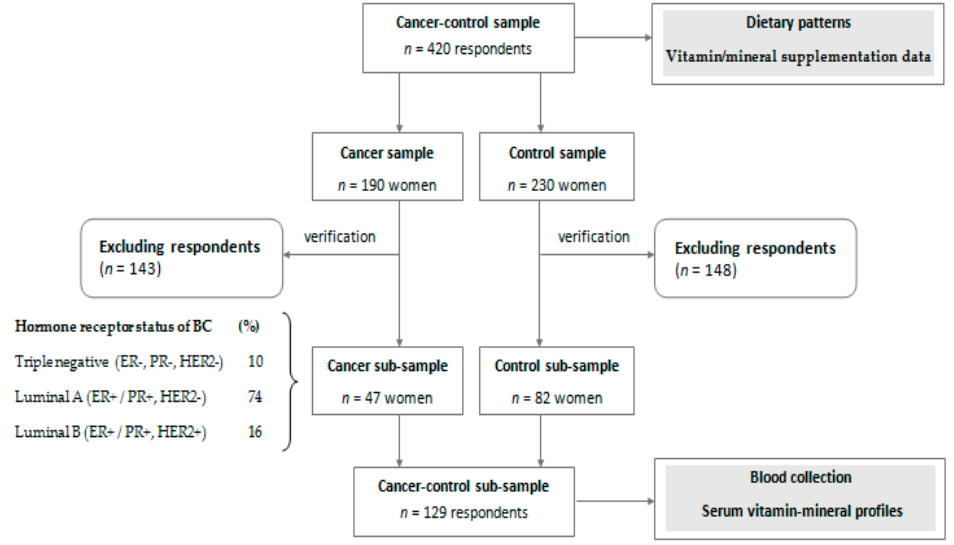
Figure 1. Study design and sample collection. BC—breast cancer; ER—estrogen receptor status of tumor; PR—progesterone receptor status of tumor; HER2—human epidermal growth factor receptor 2. Table 1. Criteria of the cancer and control sub-sample collection.